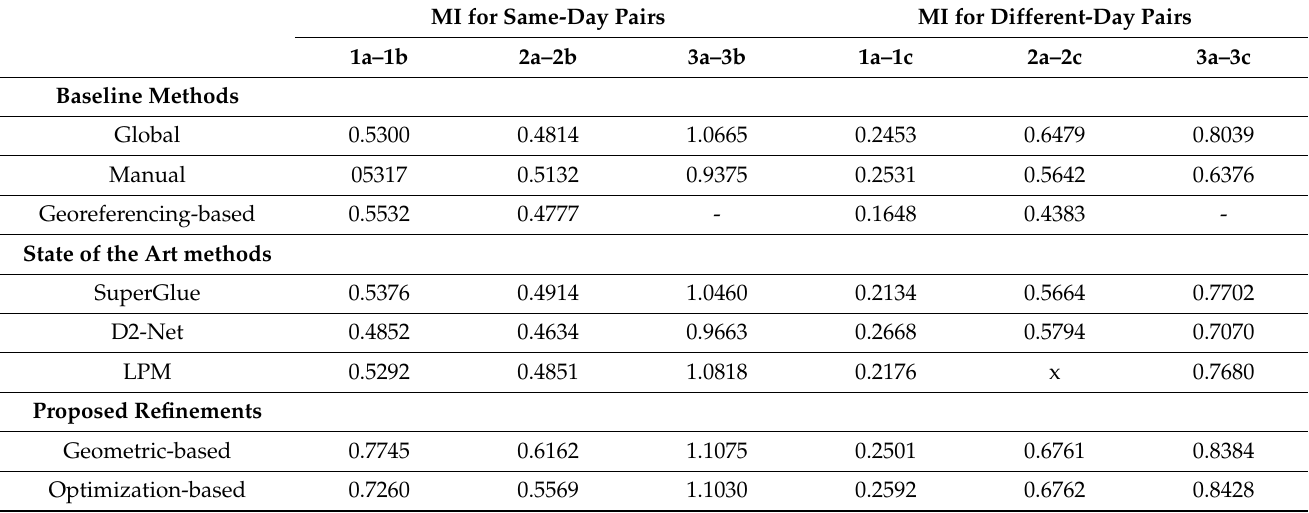
Table 7. Mutual information (MI) results between transformed and reference images for the proposed global, geometric- based, and optimization-based approaches with the baseline and state-of-the-art image registration methods. Note that there are no geo-coordinates provided for the images 3a, 3b, and 3c. MI for Same-Day Pairs MI for Different-Day